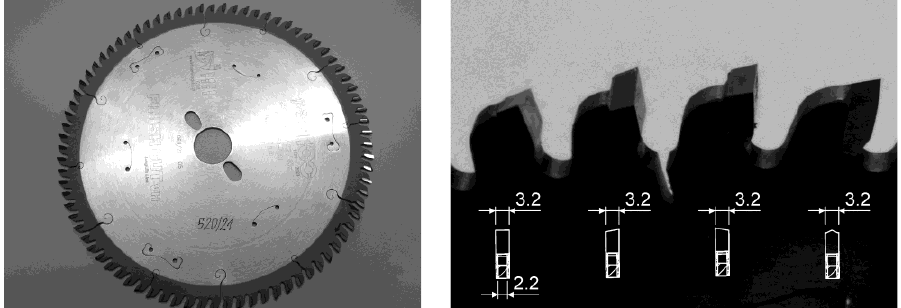
Figure 1. Circular saw blade used for investigations ( left ) and its GSML teeth geometry ( right ).